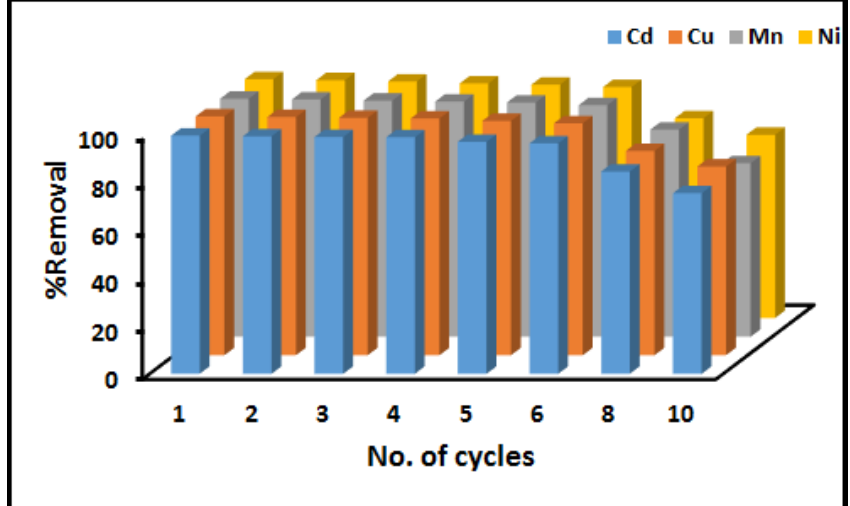
Figure 8. Results obtained from the reusability and regeneration studies.